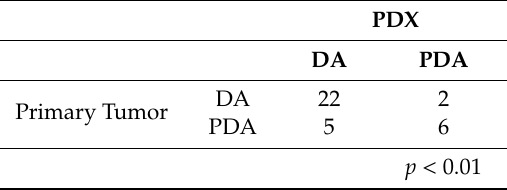
Table 4. Concordance of histological differential grade between Primary and CDX tumors.